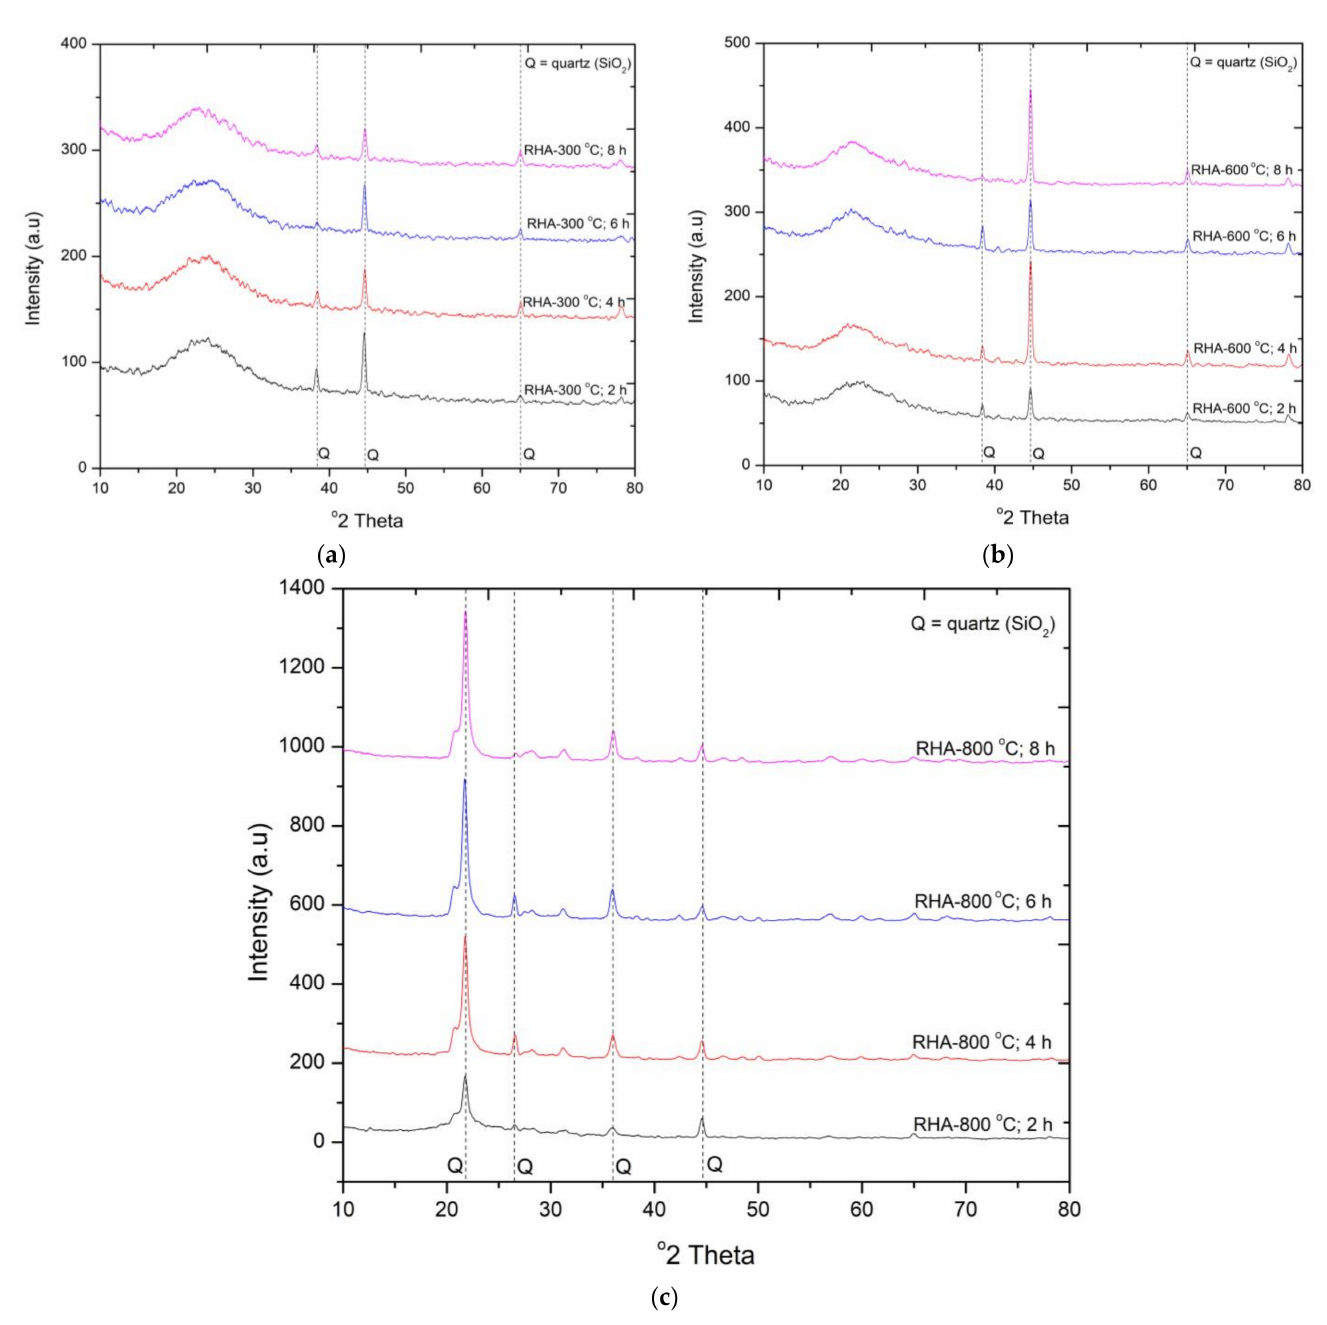
Figure 1. XRD pattern of rice RHA calcinated at ( a ) 300 ◦ C ( b ) 600 ◦ C and ( c ) 800 ◦